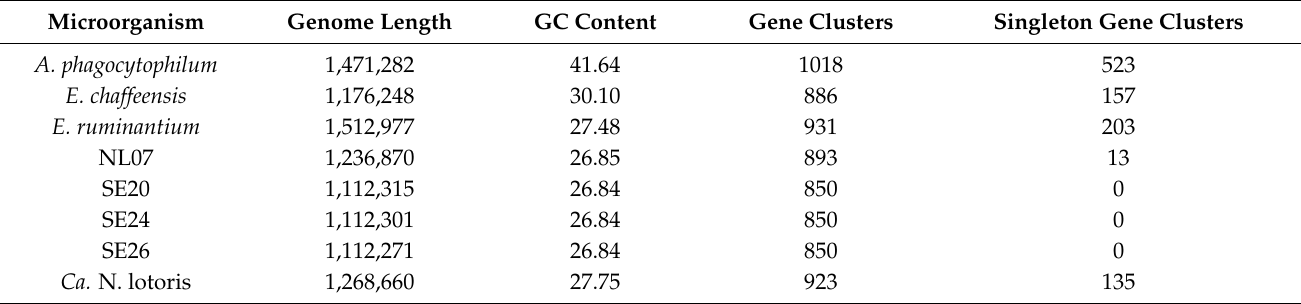
Table 5. Summary of analyzed genomes.